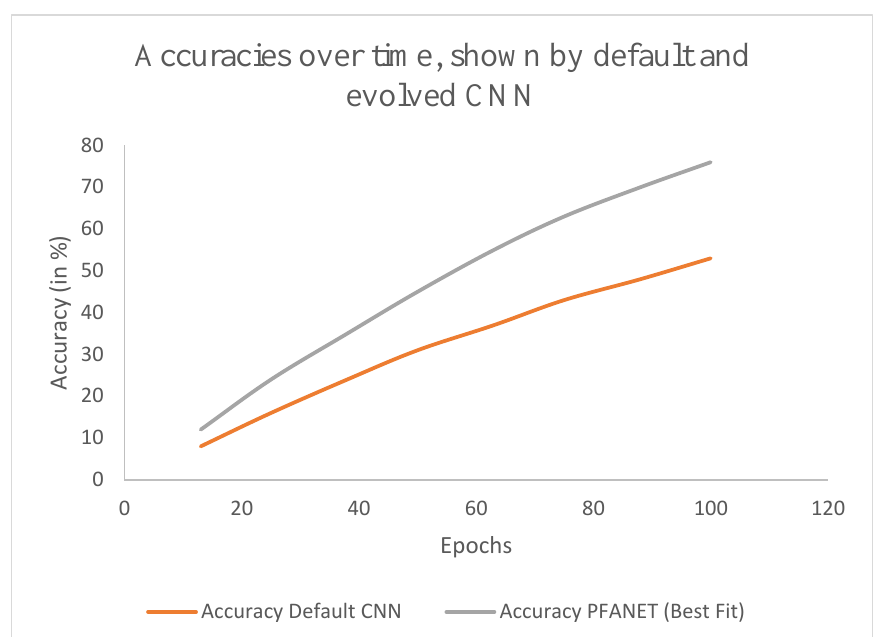
Figure 6. Accuracy change in evolved CNN vs. Default CNN.